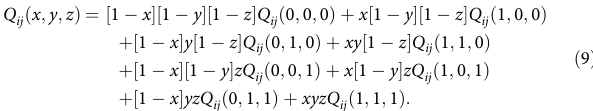
where ( x, y, z ) with x , y , z ∈ [0,1] denotes a location within a selected cube of eight neighboring points of a square lattice; each point is in the corner of the cube and the corners are labeled with vector of 0 and 1. Performing the calculation of spherical multipole coef fi cients on the discrete grid, the integral (Eq. (7)) reduces to the discrete Fourier transform and the use of the Gauss – Legendre quadrature replaces the integral (Eq. (8)) with the sum